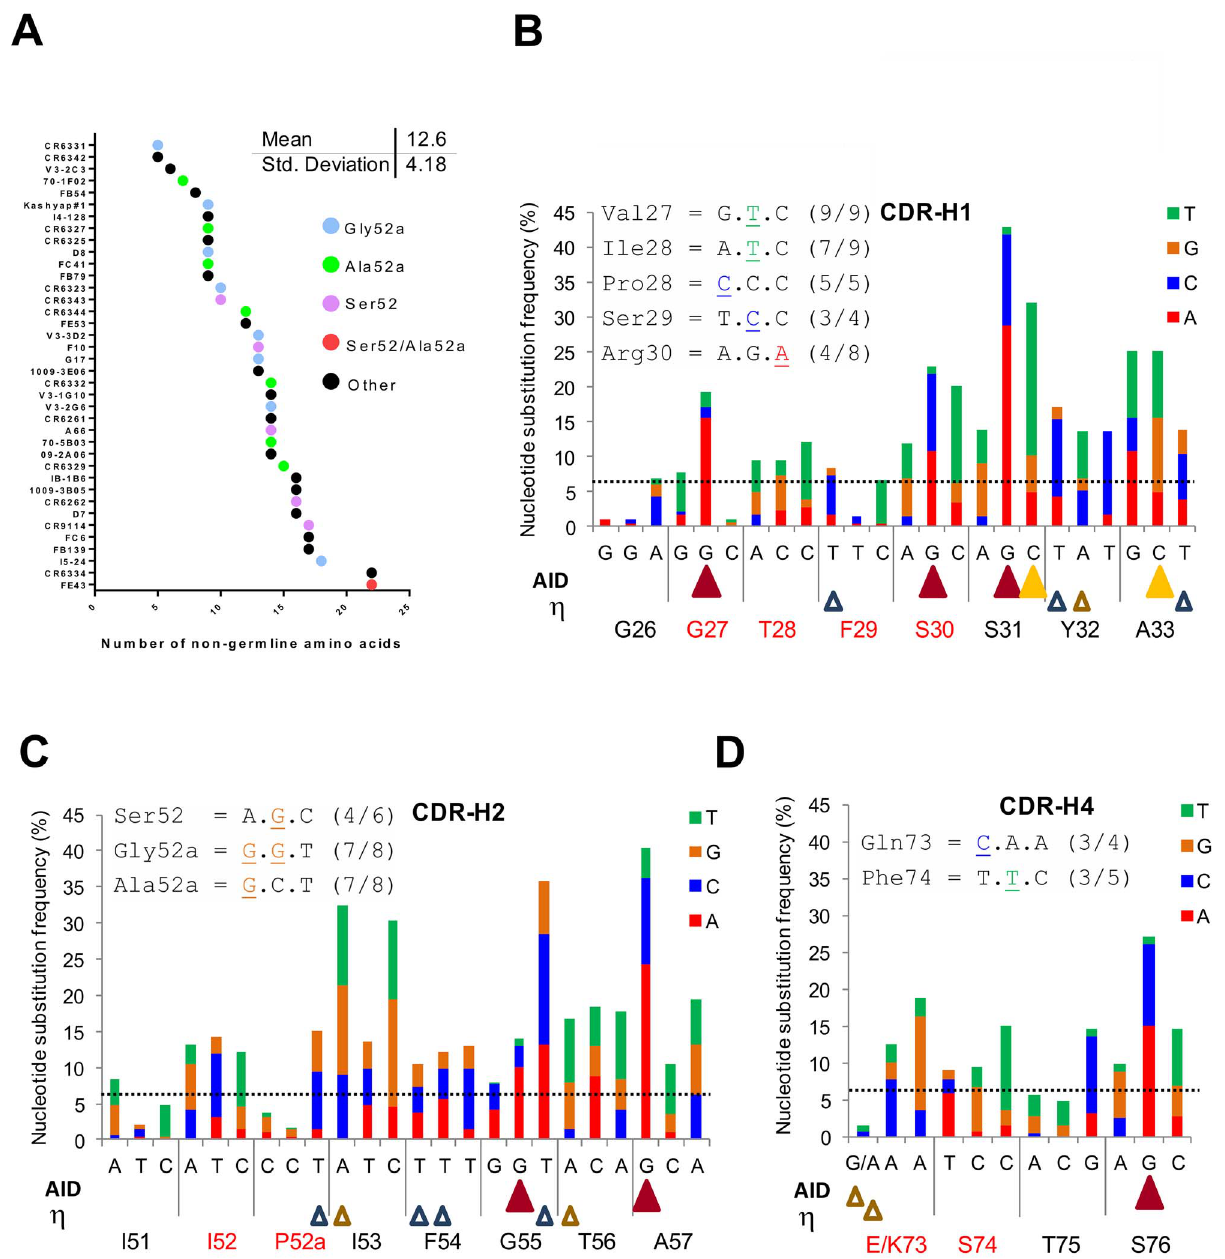
Figure 3. Studying the location of SHM hotspots and nucleotide substitutions frequencies in the IGHV1-69 reference Ab dataset. A ) Number of V-segment substitutions observed in 38 HV1-69-sBnAbs with color notations that designate the HV1-69-sBnAbs characterized by the distinctive CDR-H2 Ser52 or Ala/Gly52a and ‘‘other’’ which do not contain CDR-H2 Ser52 or Ala/Gly52a. ( B–D ) Upper panel – the common nucleotide substitutions that generated the distinctive amino acid substitutions in the respective CDR domain. Main panel - The IGHV1-69 51p1 Ab reference dataset was studied for substitution frequency of nucleotides in the V-segment CDRs and for location of AID and pol g hotspots (AID=WRCY yellow solid triangle/RGYW dark red solid triangle, Pol g WA brown open triangle/TW blue empty triangle. The horizontal line shows the mean 6 SD (6.44 6 7.23) of non-germline nucleotide substitution frequency observed for FR regions to serve as a reference.